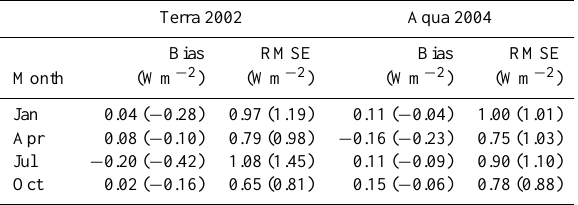
Table 2. Regional mean TOA LW flux bias and RMSE by season derived from direct integration, using ADMs developed by Su et al. (2015) for the Edition 4 SSF data, and ADMs developed by Loeb et al. (2005) for the Edition 3 SSF data (shown in parentheses) for Terra 2002 and Aqua